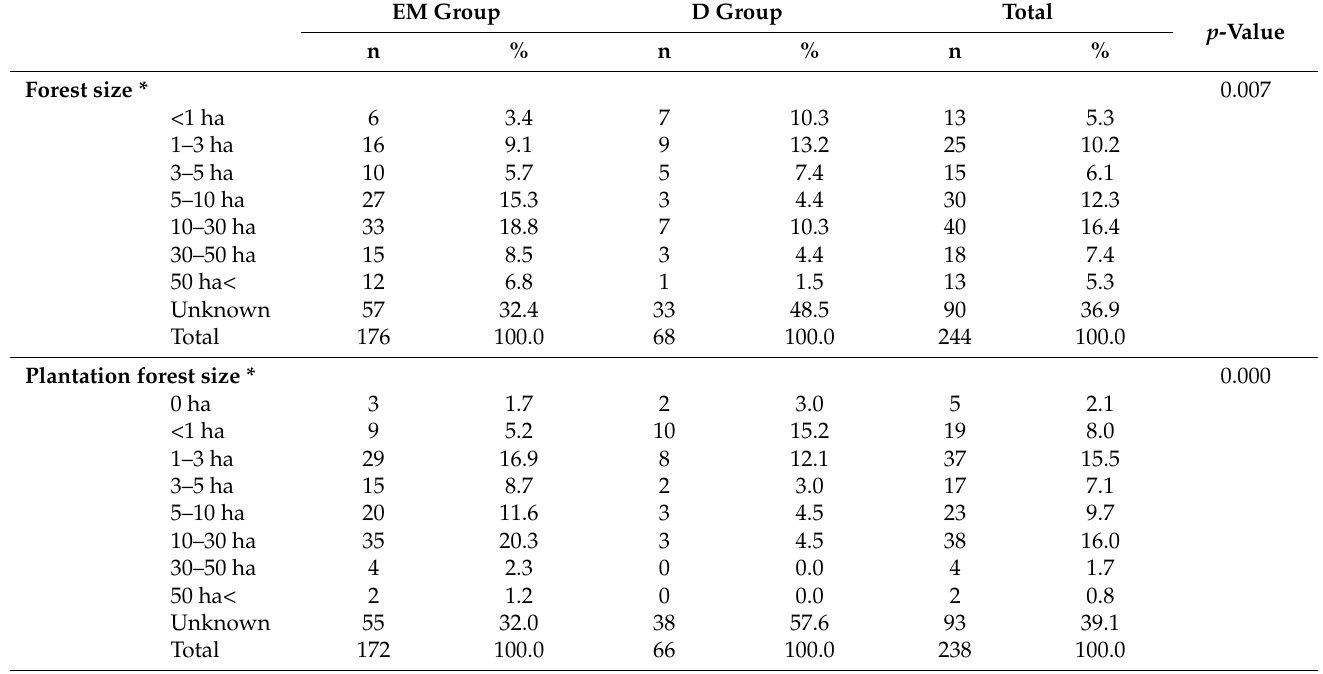
Table 8. Comparison of forest conditions between the two groups in